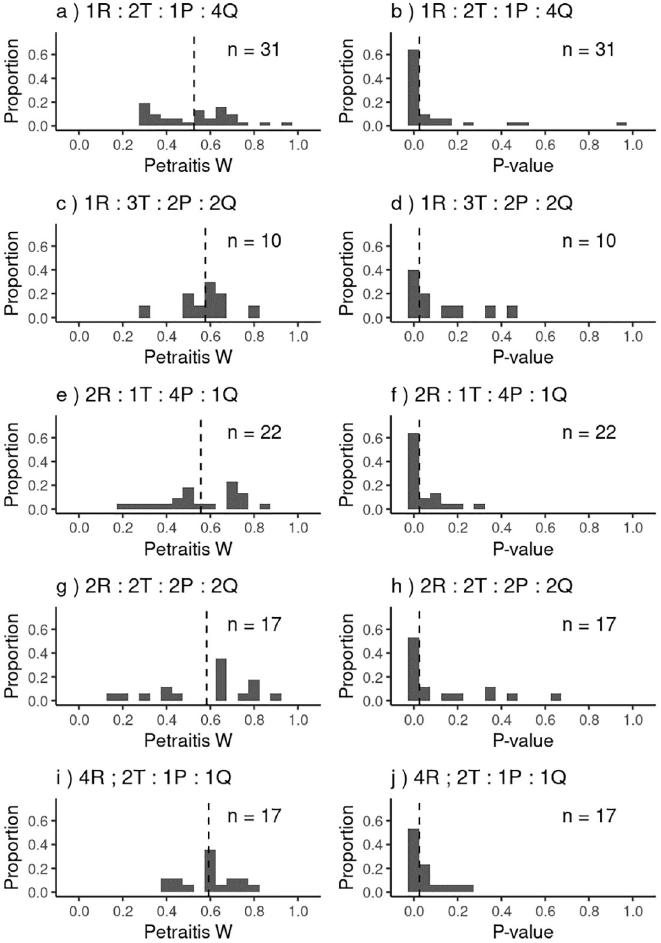
Fig 6. Histogram of W -values with corresponding P -value distribution for A. helena in each treatment. Petraitis i W i -values (left column) indicate the level of individual specialisation compared the the population diet. Higher values indicate a diet more similar to that of the population as a whole. The population mean deviation is indicated by the vertical dashed line. Histogram of P -values (right column), significant values ( < 0.05; left of the dashed vertical line) indicate a diet breadth narrow than that of the population, i.e. less variation in prey species